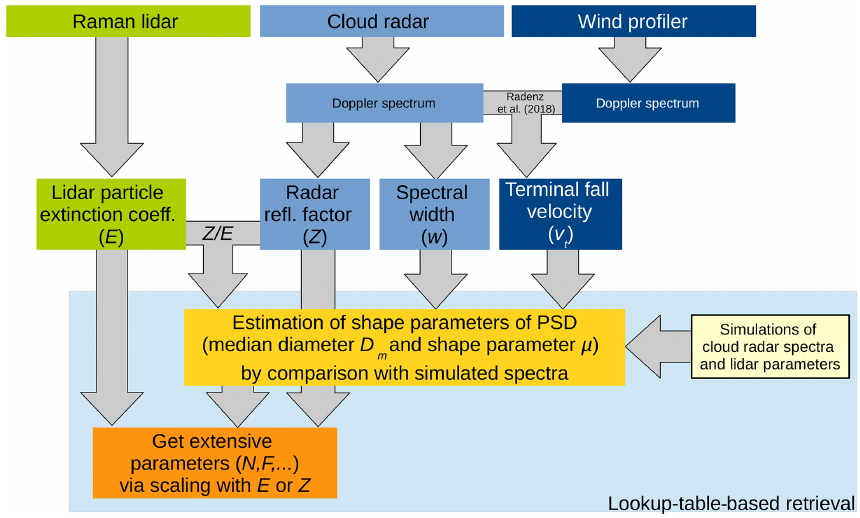
Figure 4. Flowchart of the retrieval algorithm, illustrating the synthesis of data from the remote-sensing instruments with the simulated